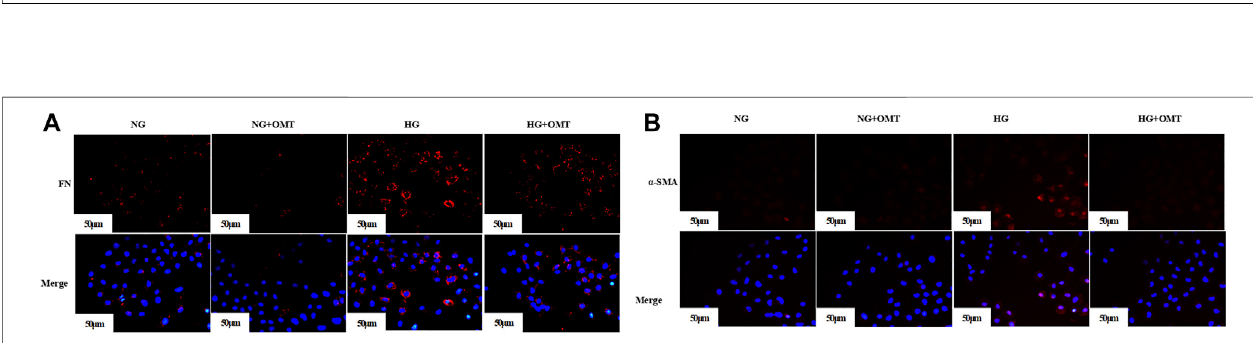
FIGURE 10 | (A) The expression of FN in cells was detected by immuno fl uorescence (scale bar is 50 μ m). (B) The expression of α -SMA in cells was detected by immuno fl uorescence (scale bar is 50 μ m).